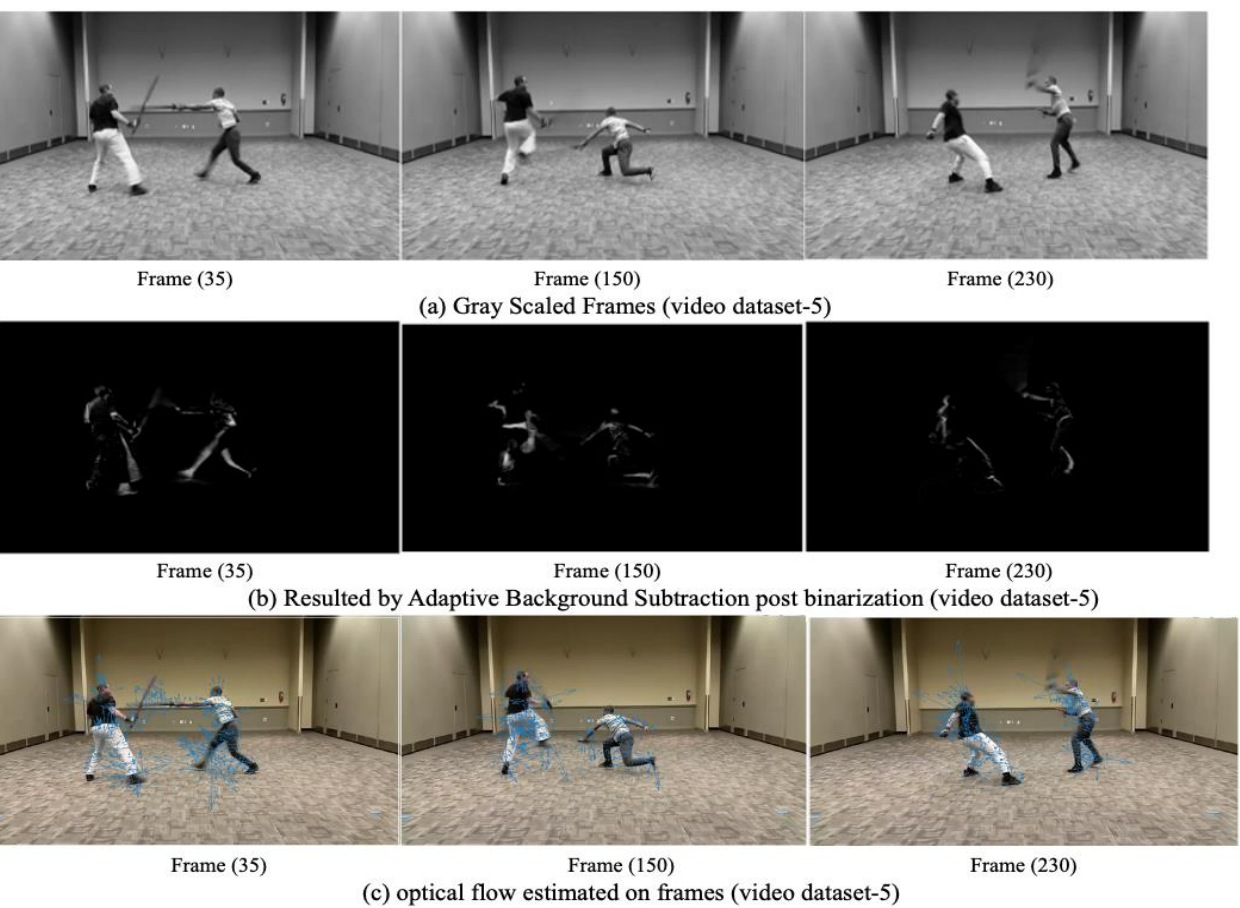
Figure 11. Activity map and pixel sensitivity maps of video dataset 4 by different approaches: ( A ) by Pan et al. in [12]; ( B ) by Mehboob et al. in [13]; ( C ) by Indu, S. in [14]; ( D ) our proposed framework. E.